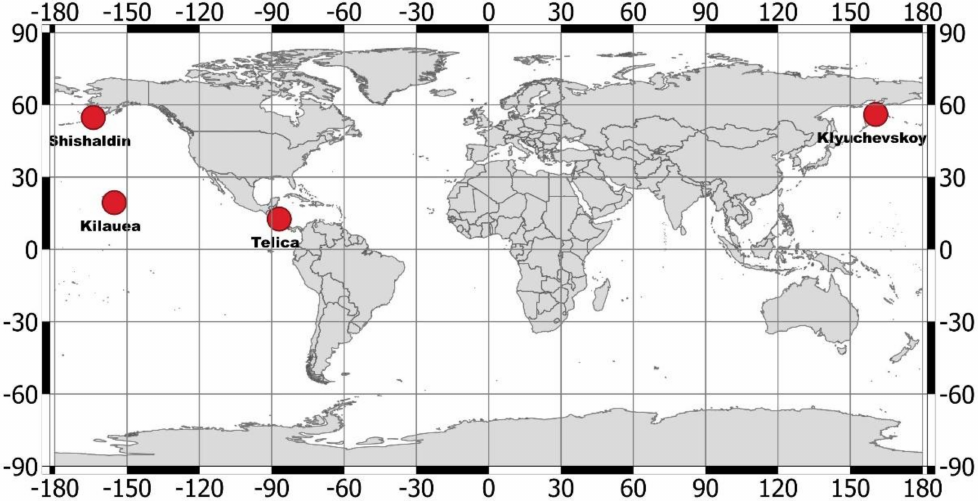
Figure 1. Geographic location of four active volcanoes analyzed in this